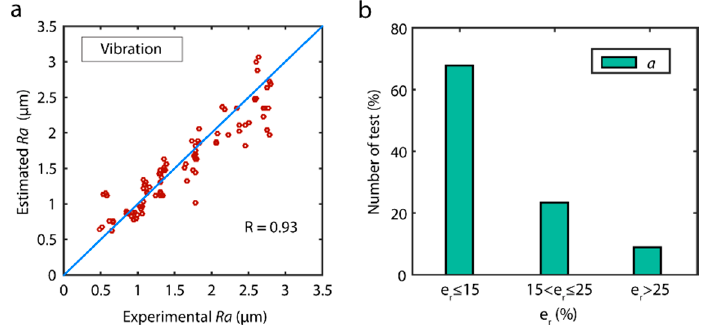
Figure 12. ( a ) Estimated data versus experimental validation data of the parameter Ra . ( b ) Reliability of predictive models.